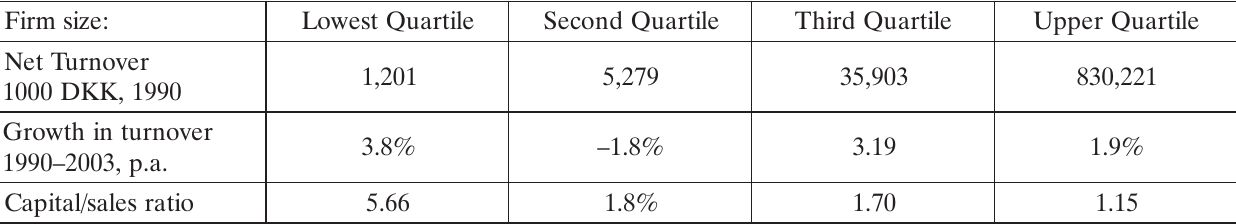
Table 2. Mean statistics by firm size for some